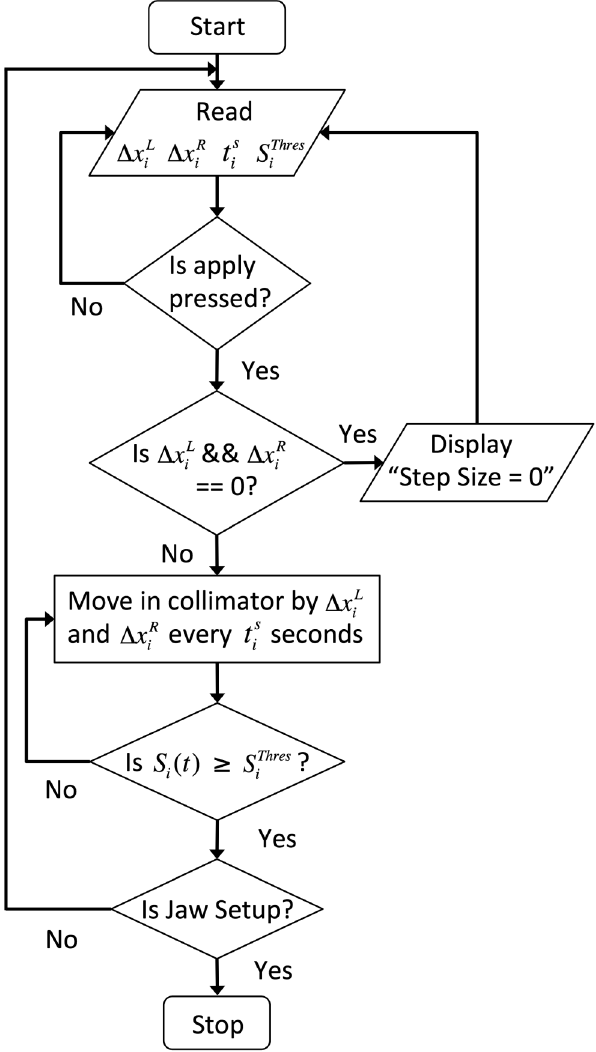
FIG. 6. The semiautomatic algorithm flowchart. The algorithm is semiautomatic as human feedback is still required at the end to check whether the BLM signal is a clear loss spike, which would indicate that the jaw is